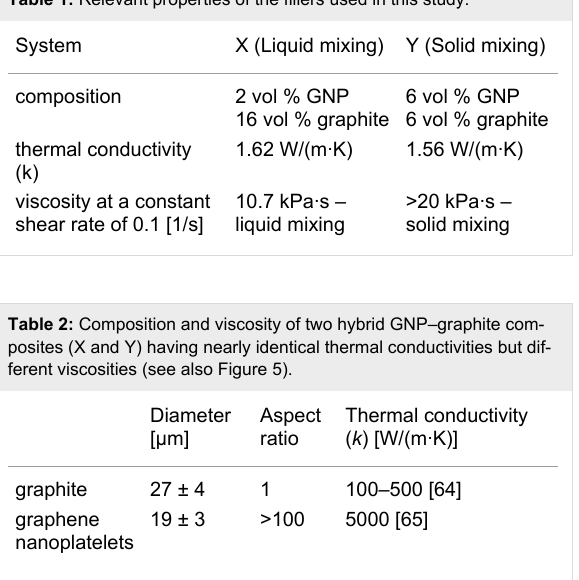
Table 1: Relevant properties of the fillers used in this study.